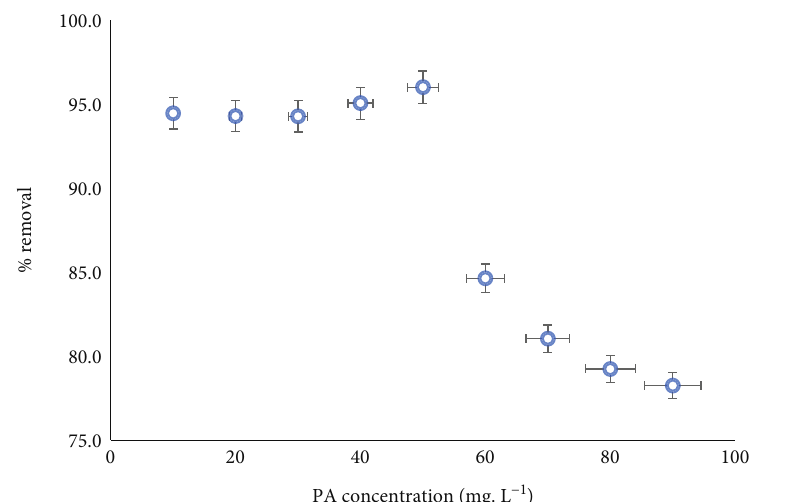
= 10 − 90mg : L − 1 ; pH = 7 : 0 , sonication i